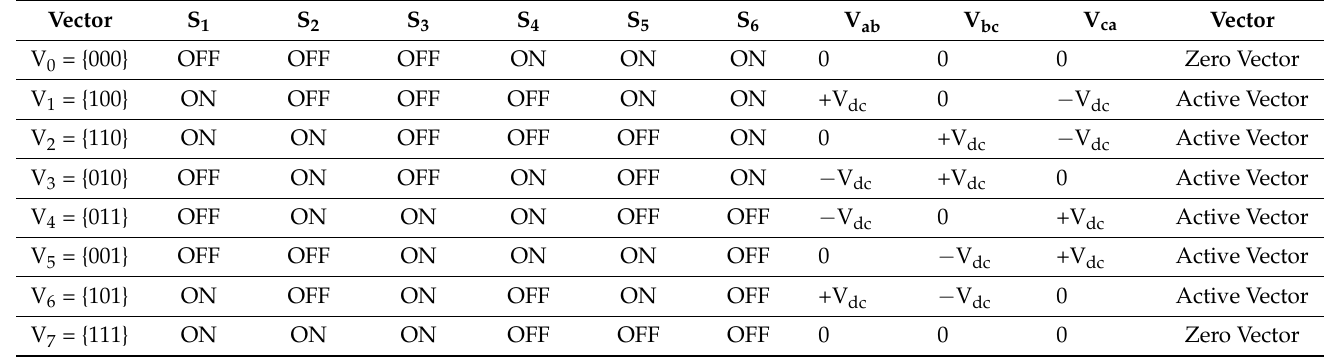
Table 1. SVPWM switching